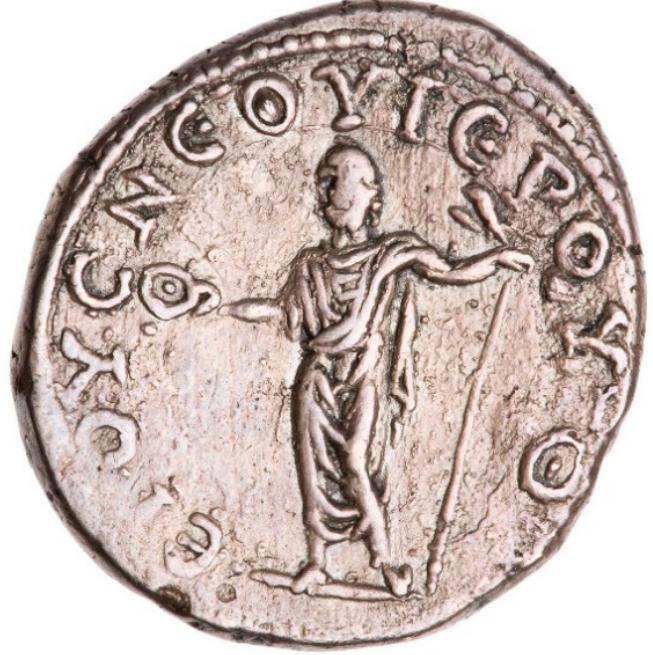
Figure 8. Reverse image of the statue of Zeus Salaminios on a silver tetradrachm minted under the authority of the emperor Vespasian for Cyprus (77–78 AD). Image courtesy of the American Numismatic Society.